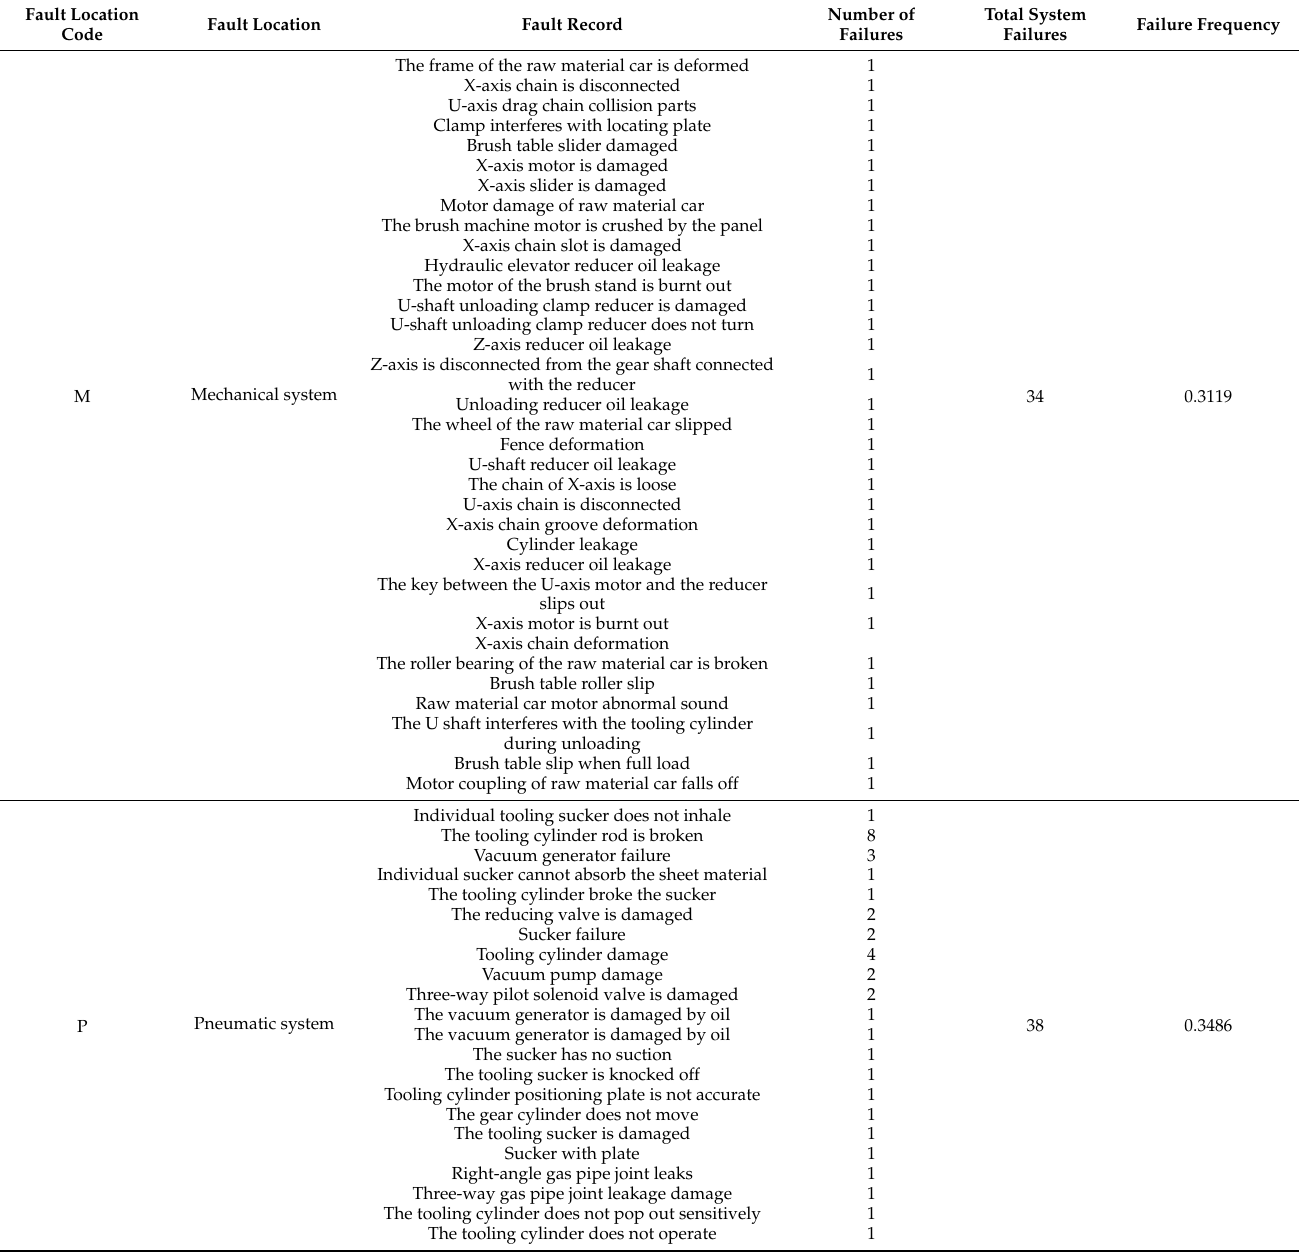
Table 9. Frequency table of the fault location of the loading and unloading truss robot for CNC